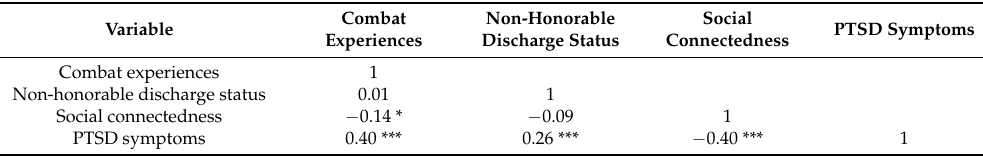
Table 1. Bivariate correlations for variables of